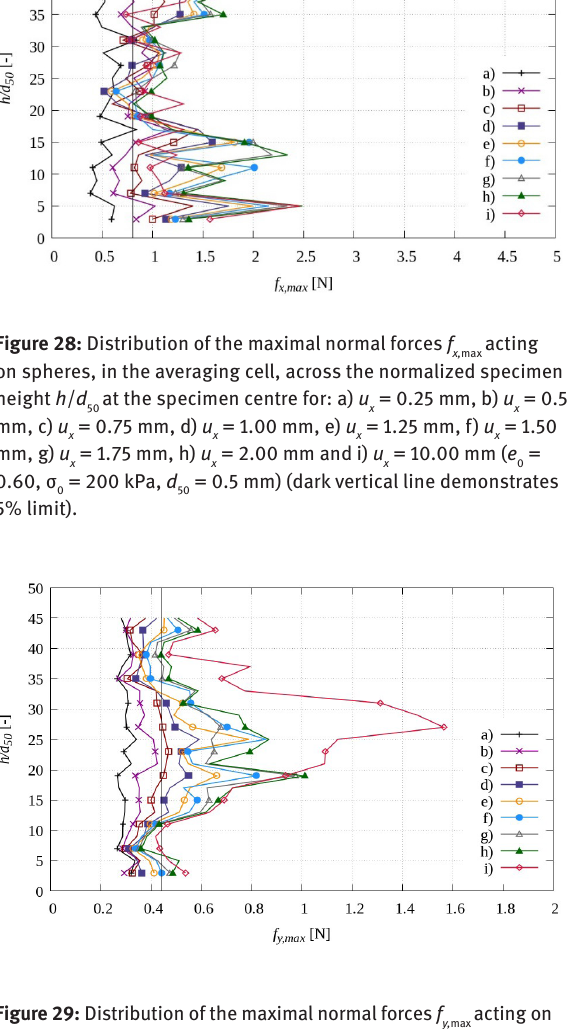
Figure 29: Distribution of the maximal normal forces f spheres, in the averaging cell, across the normalized specimen height h / d at the specimen centre for: a) u 50 u = 0.75 mm, d) u = 1.00 mm, e) u x x = 1.75 mm, h) u = 2.00 mm and i) u x kPa, d = 0.5 mm) (dark vertical line demonstrates 5% 50